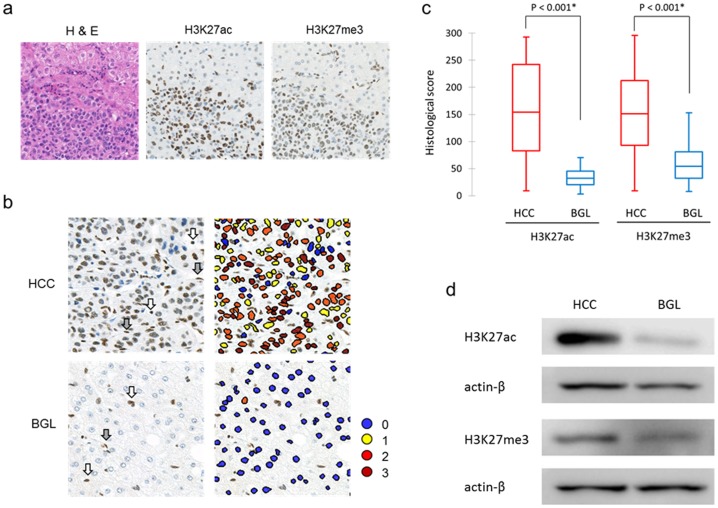
H3K27ac and H3K27me3 in HCC and background liver (BGL).(a) Images of hematoxylin and eosin (H&E), H3K27ac and H3K27me3 staining around the border between HCC and BGL. (b) Images of HCC and BGL samples by objective-quantitative analysis with Tissue Studio (Definiens AG, Munich, Germany). Each nucleus was assigned scores of 0 (negative), 1 (weakly positive), 2 (moderately positive) or 3 (strongly positive). Inflammatory cells (white arrows) and endothelial cells (gray arrows) were excluded in this analysis. (c) Distributions of histological scores (H-scores) for H3K27ac and H3K27me3 in HCCs and BGLs using box-plots. Statistical analyses were performed using the Mann-Whitney test. (d) Western blot showing increased levels of H3K27ac and H3K27me3 in HCCs compared with the matched non-cancerous liver. Actin-β was used as a loading control.